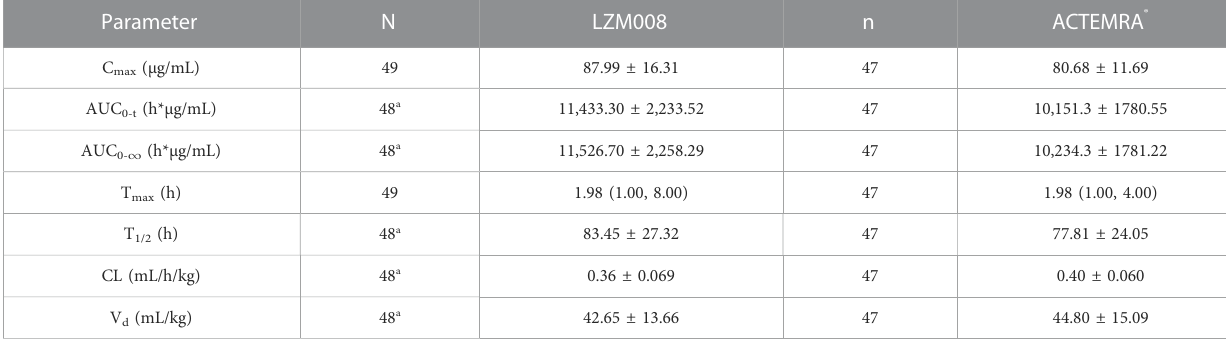
TABLE 2 Summary of PK parameters of LZM008 and ACTEMRA ® after a single infusion of 4 mg/kg. Parameter